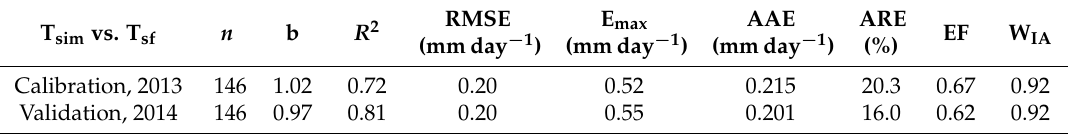
Table 4. Goodness of fit indicators relative to SIMDualKc predicted transpiration values when compared with observed transpiration data derived from sap-flow